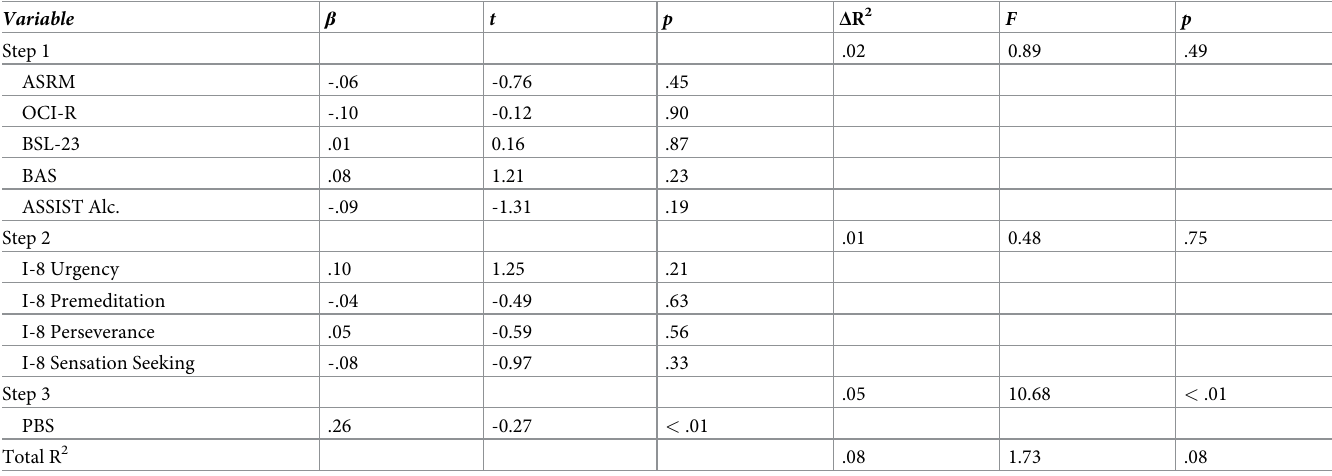
Table 2. Multiple regression predicting the stroop matching